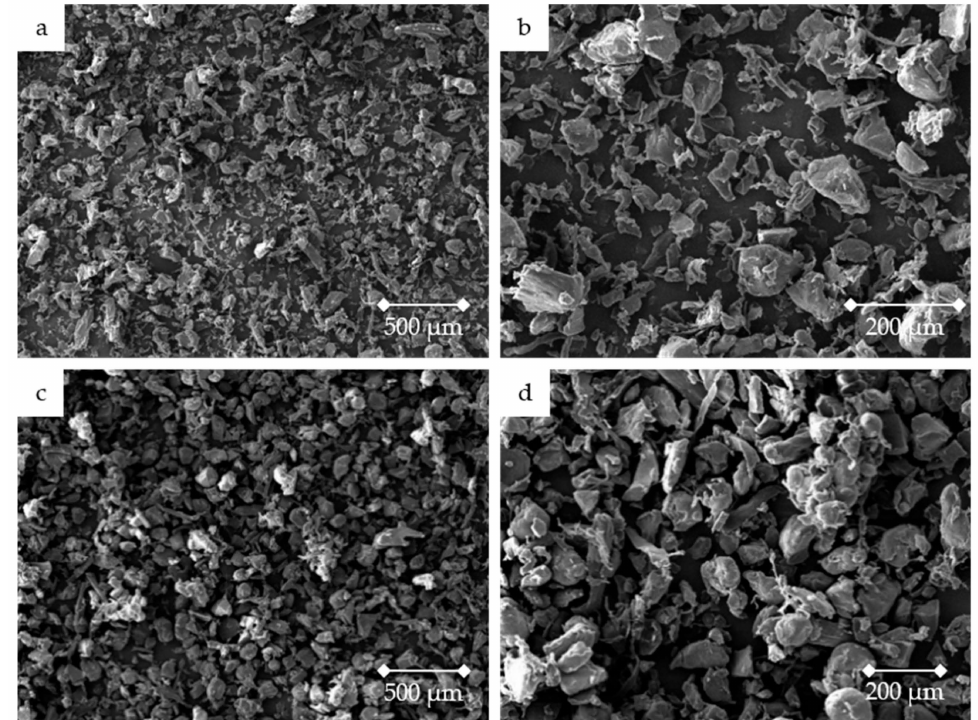
Figure 6. SEM images of the particles of the used polyamide 12 sinter material: ( a , b ) before the first process cycle at 46 × and 150 × magnification; ( c , d ) after the fifth process cycle at 46 × and 105 × magnification. Generated with Tescan Mira 3. Various particle agglomerates were visible in the powder after the fifth process cycle, with diameters up to 250 µ m. In particular, small particles agglomerated to larger